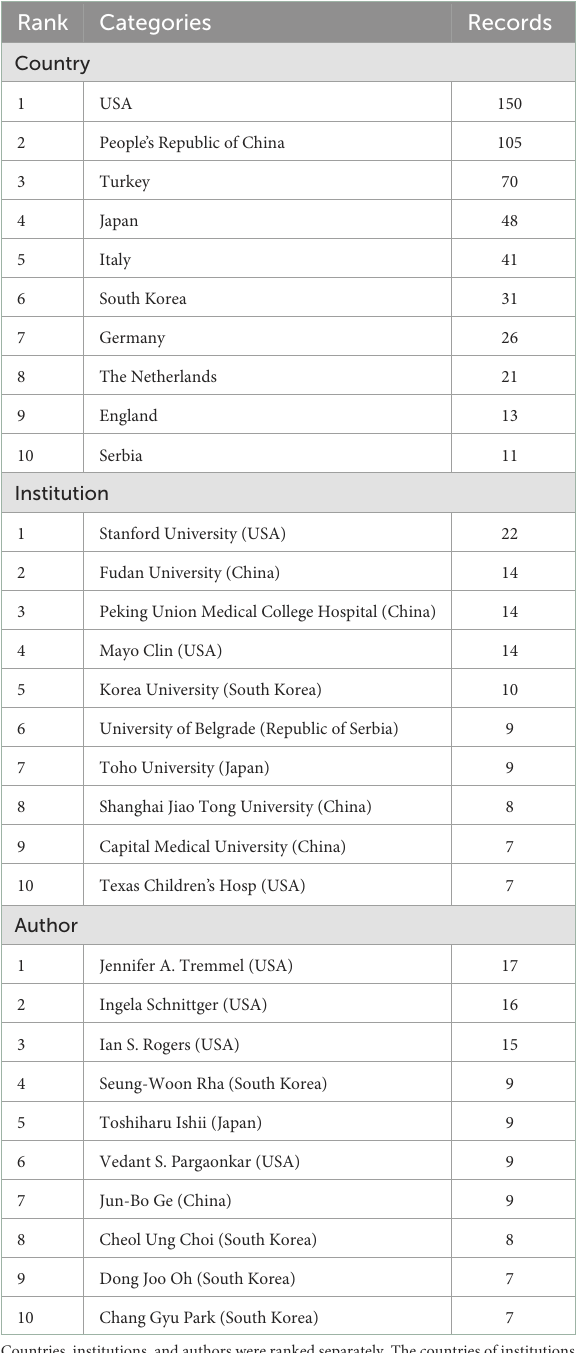
TABLE 1 Top 10 active countries, institutions, and